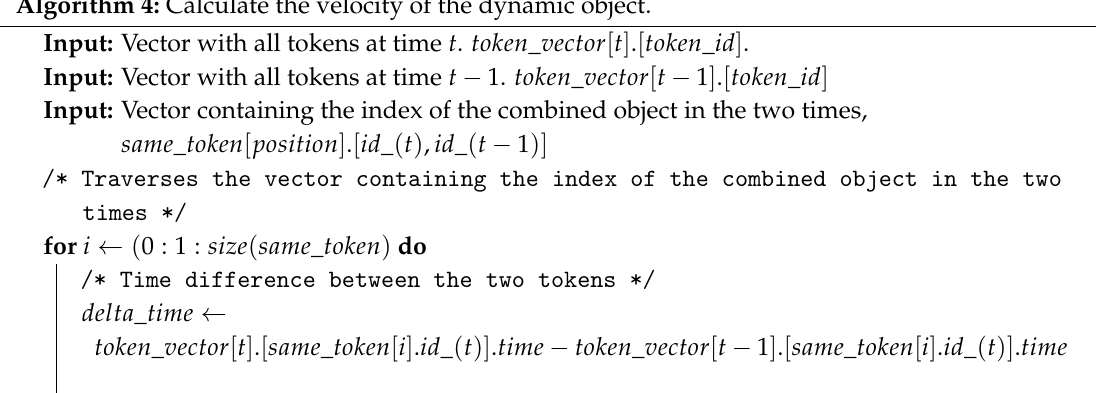
Algorithm 4: Calculate the velocity of the dynamic object.